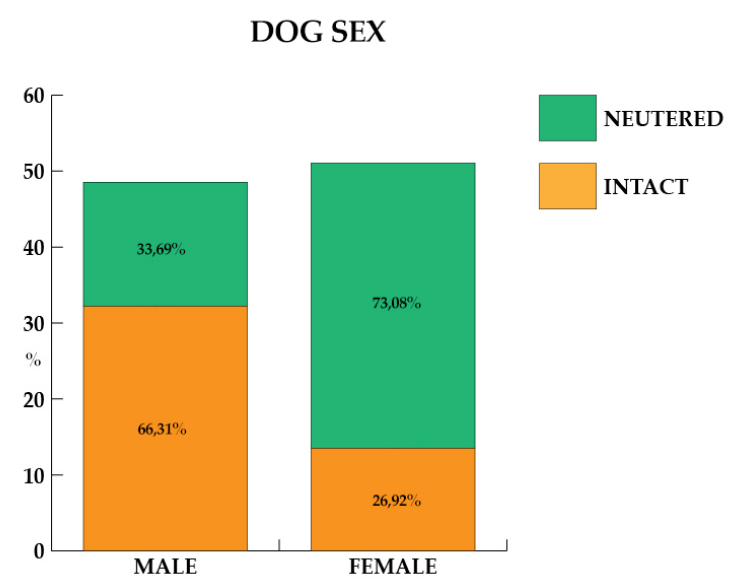
Figure 2. Percentage of dogs’ sex, distinct in intact and neutered dogs.